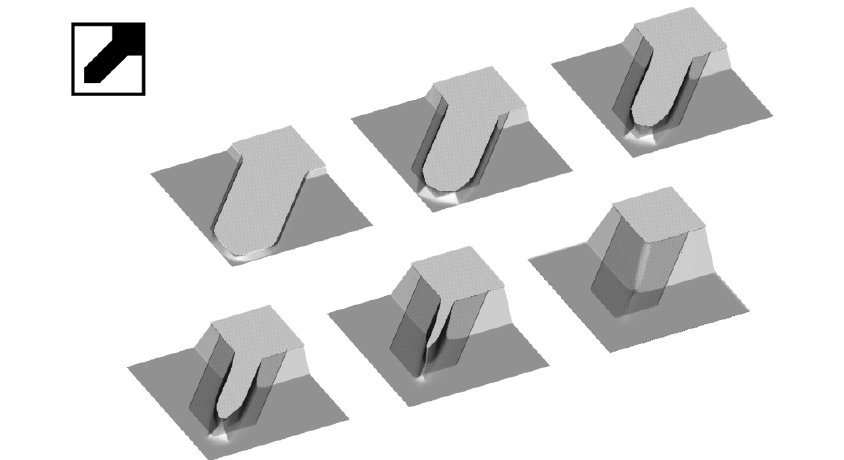
Figure 10. Convex corner compensation in mesa structure fabrication. Compensation mask is shown in the upper left corner. Initial aperture is aligned to <110> directions. Profiles at six equidistant time moments, with the dotted mask superimposed, are